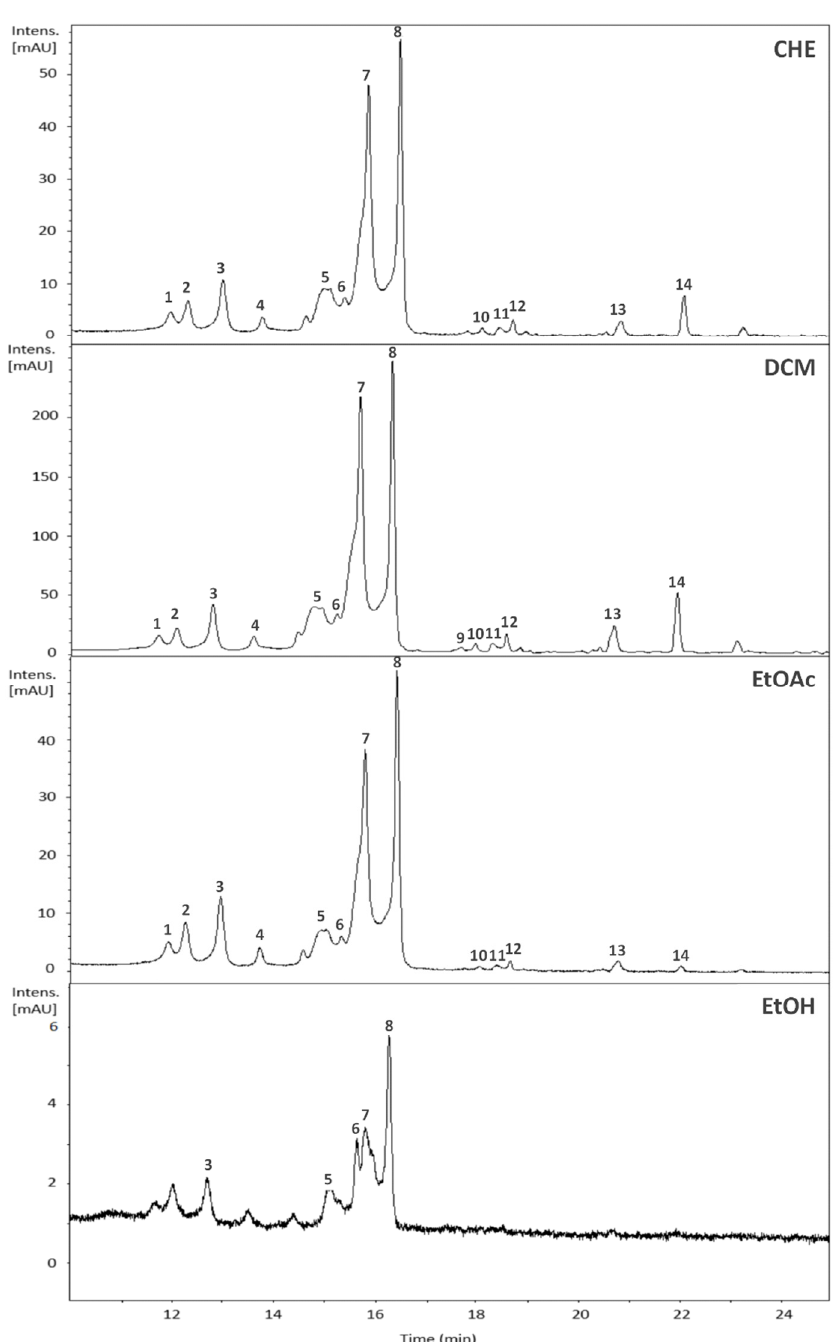
Figure 1. Expansion of total ion chromatograms (10–25 min) of CHE (crude hydroethanolic extract), DCM (dichloromethane fraction), EtOAc (ethyl acetate fraction), and EtOH (hydroethanolic fraction) from B. holophylla